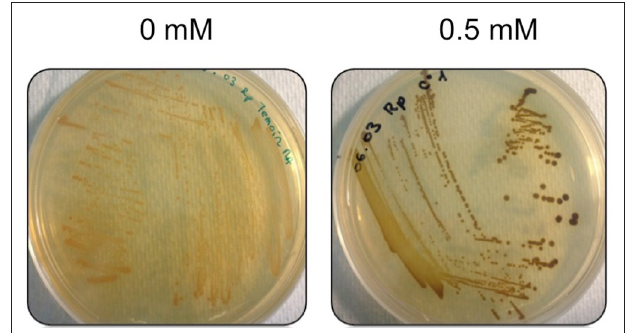
FIGURE 9 | Morphotypes of E. mobile BBCC367 in presence of